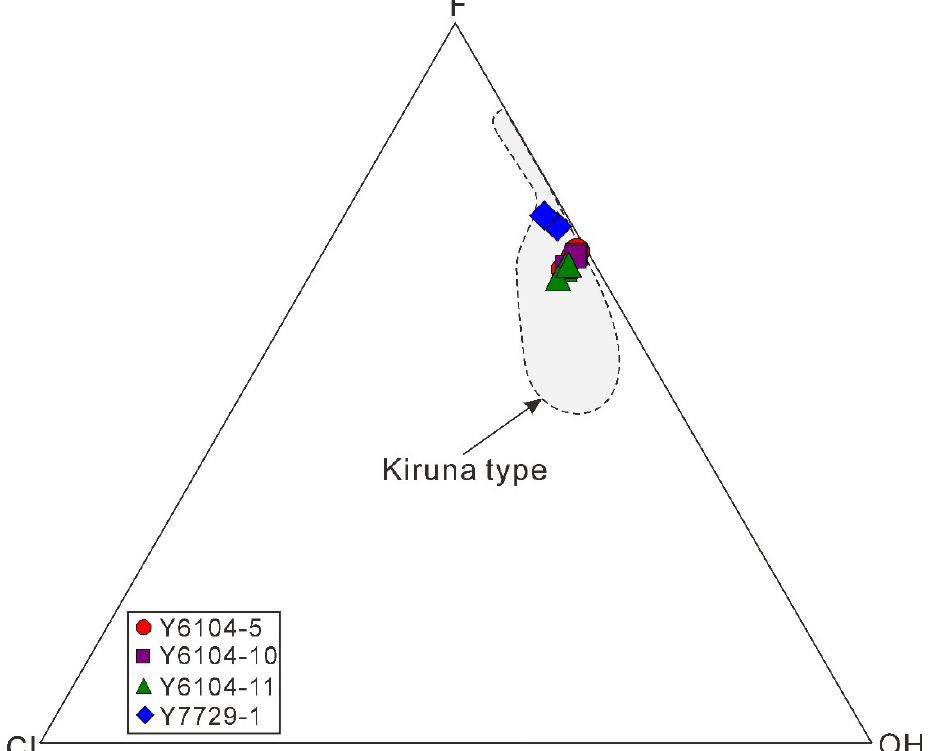
Figure 6. F-Cl-OH diagram showing compositional variation (atoms per formula unit) in apatite (modified after